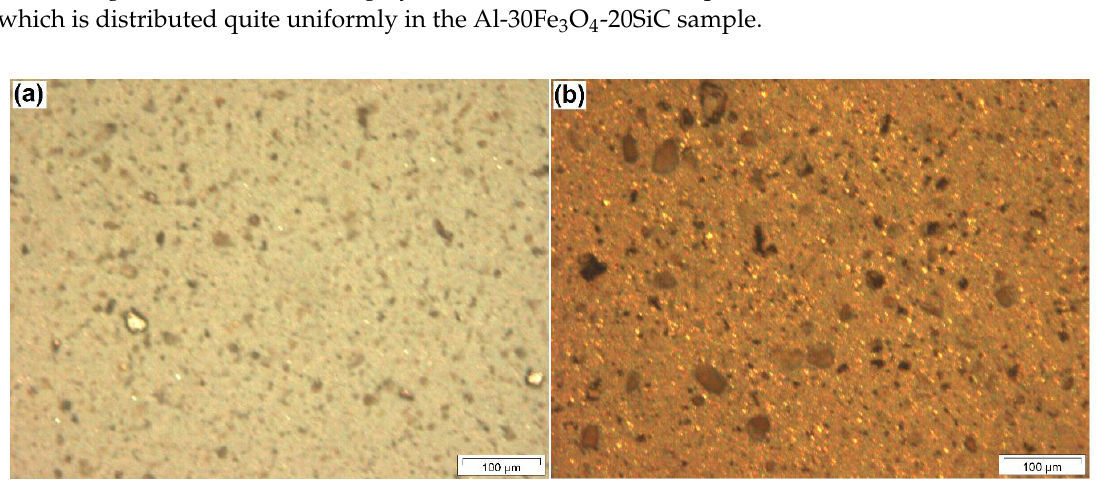
3 O 4 and ( b ) Al-30 Fe 3 O 4